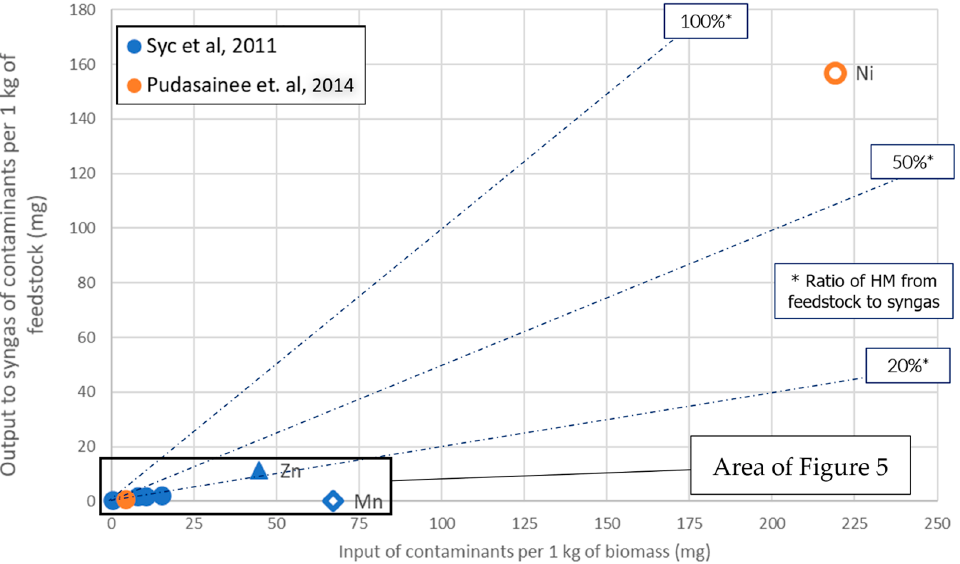
Figure 4. Gasification: Output to syngas vs. input with feedstock of HM species. All available input loads shown. Adapted from